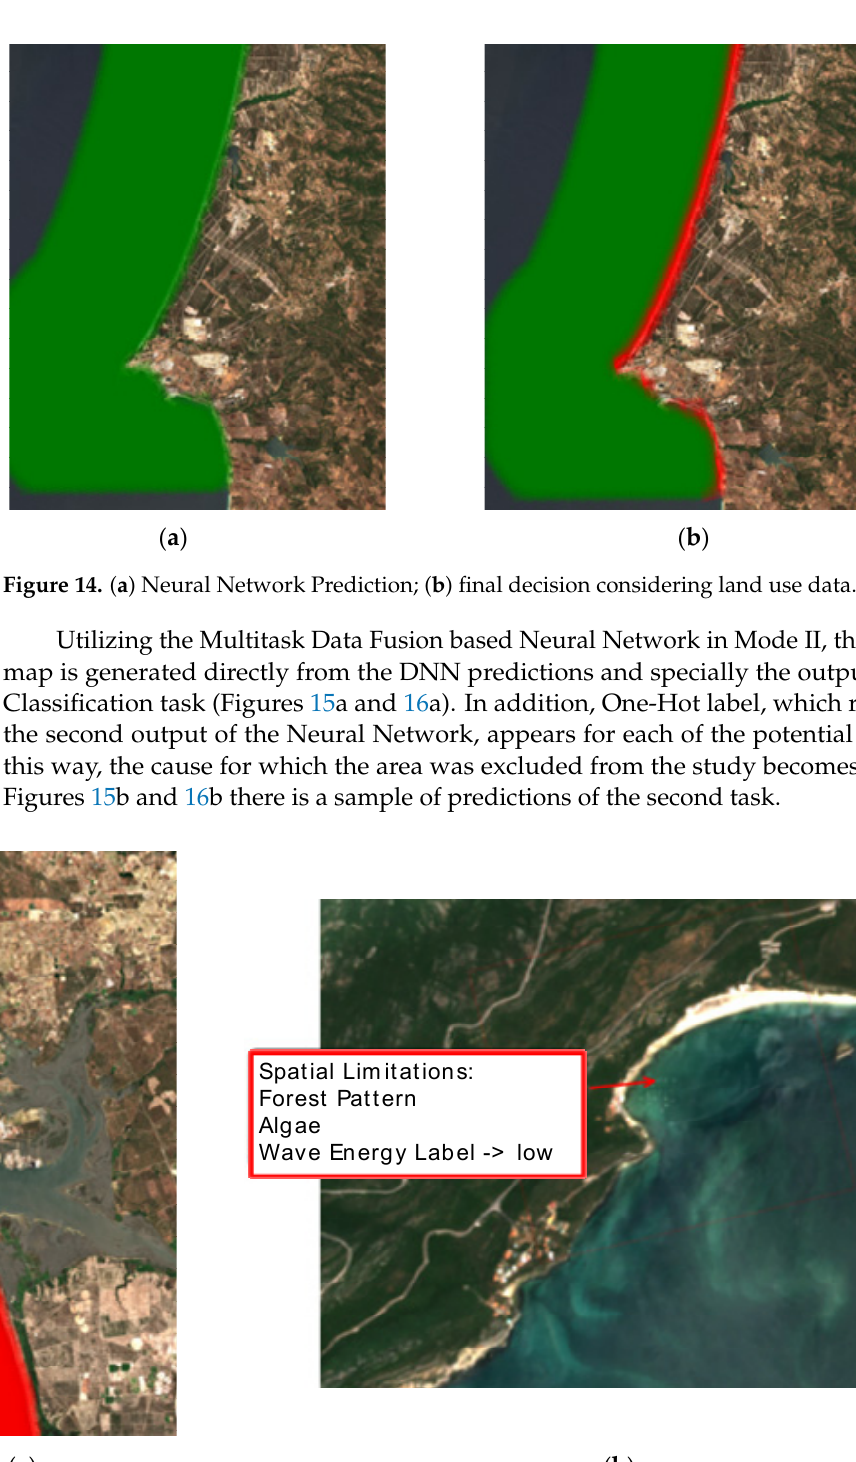
Figure 15. ( a ) Suitability map—Neural Network Predictions; ( b ) zoom to observe Multilabel Classification results.